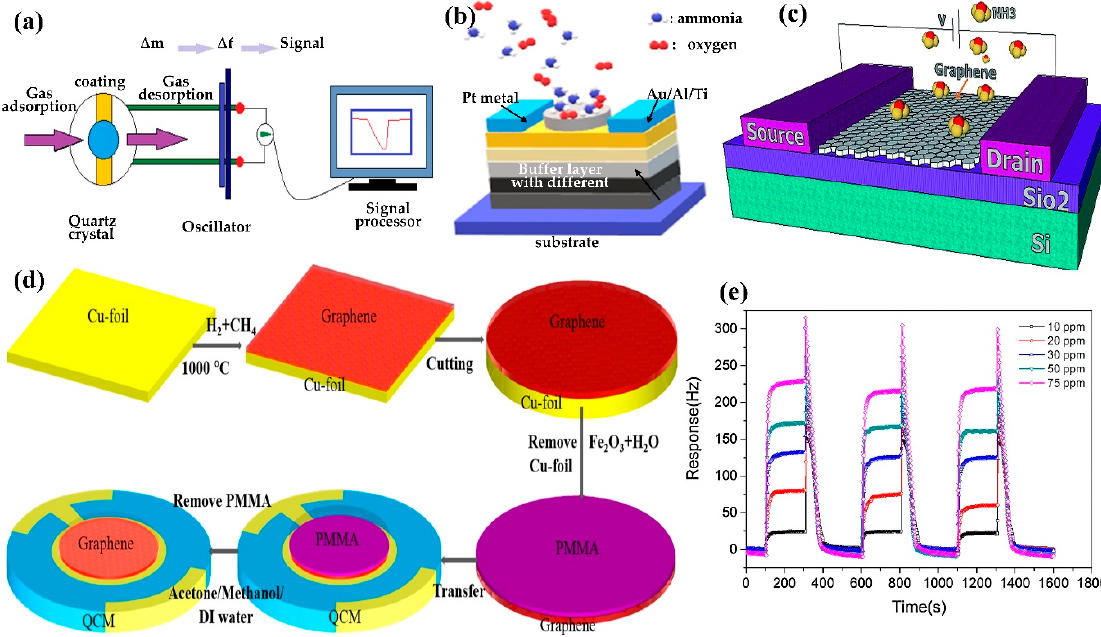
Figure 11. Schematic diagram of the ( a ) QCM, ( b ) tunnel FET, and ( c ) heterostructure electrostrictive FET for NH 3 detection. Adapted with permission from [169]. Copyright RCS 2016. ( e ) Dynamic response–recovery curves of the QCM gas sensor prepared using GO/chitosan nanocomposite. Adapted with permission from [170]. Copyright Elsevier 2017.